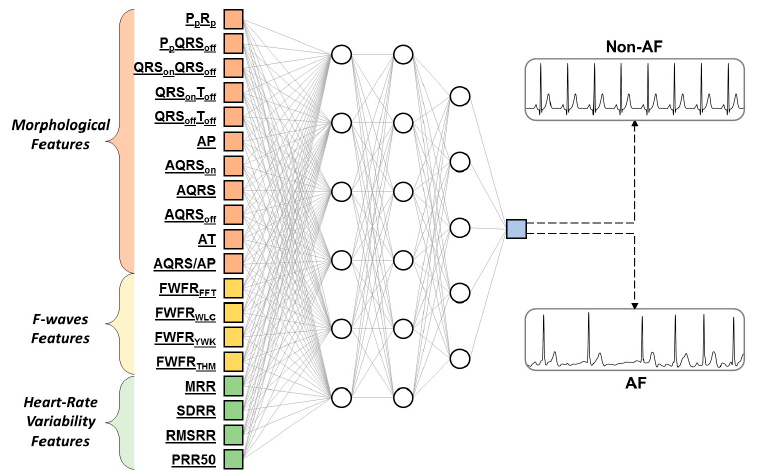
Figure 2. The optimal artificial neural network obtained by the repeated structuring and learning procedure (RSL_ANN). It presents a three hidden layer architecture with 6 neurons in the first hidden layer, 6 neurons in the second hidden layer and 5 neurons in the third hidden layer.